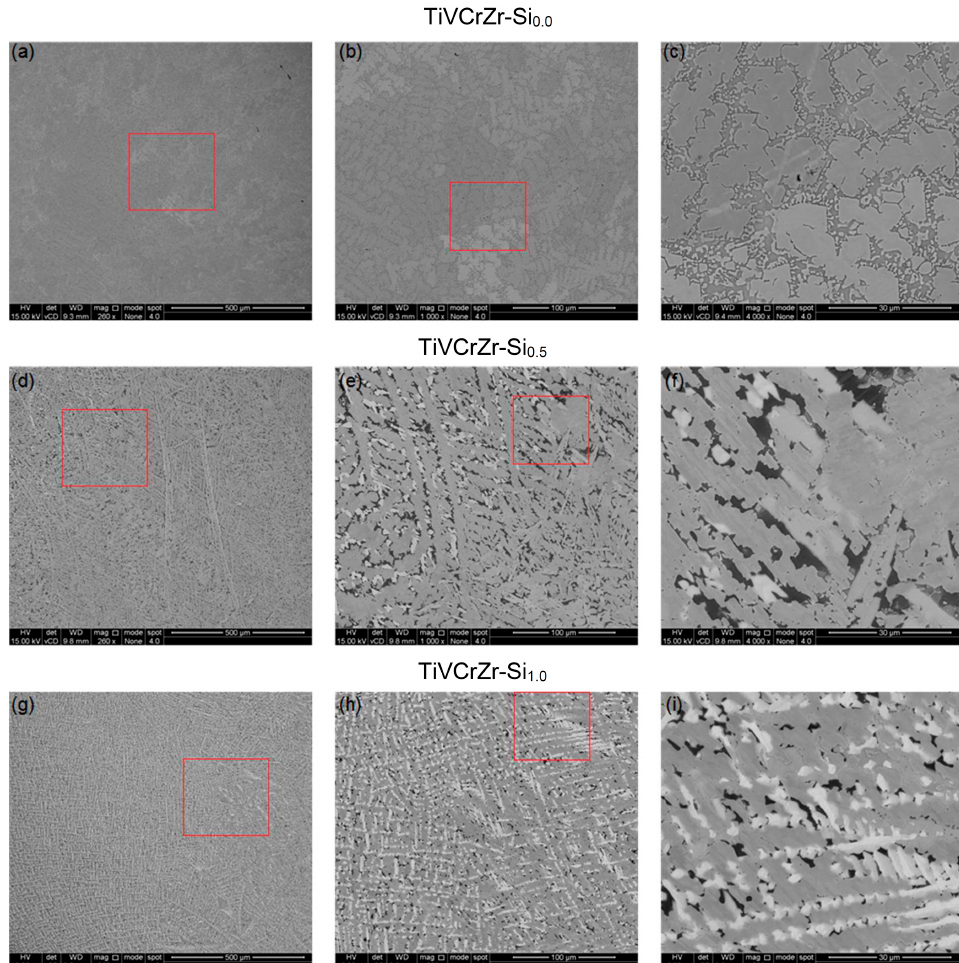
Figure 4. Backscattered electron (BE) SEM images of the microstructure of TiVCrZr ‐ Si x (where micrographs of x = 0 are shown in the top row, micrographs of x = 0.5 are shown in the middle row, and micrographs of x = 1.0 are shown in the bottom row). From left to right, the images are shown in order of their magnification (276×, 1000×, and 4000×, respectively), with the red boxes indicating zoomed regions of ( a – c ) x = 0, ( d – f ) x = 0.5, and ( g – i ) x = 1.0.